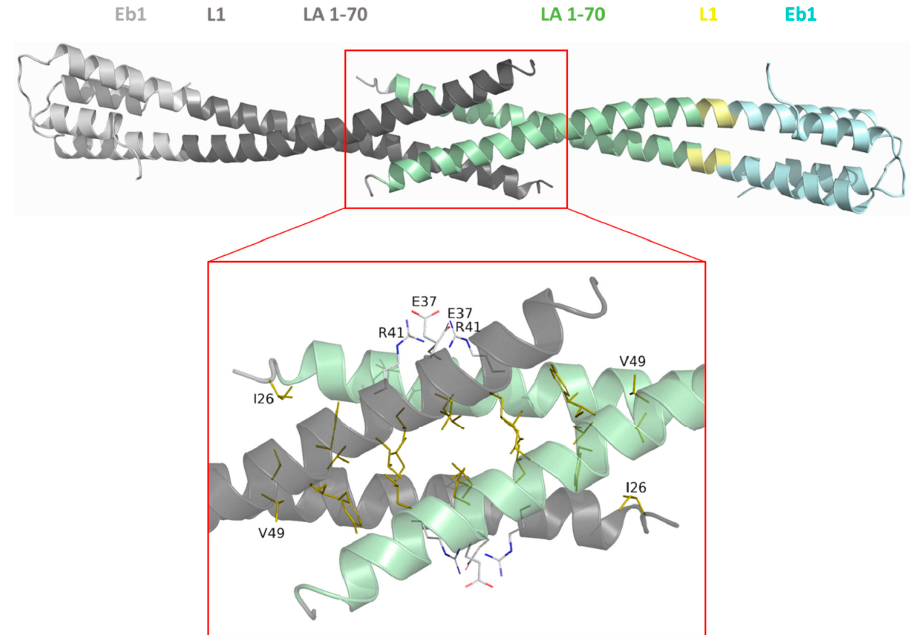
Figure 4. Crystal structure of LA 1-70-Eb1 dimer with coil1A in green, L1 region in yellow and the Eb1 cap in cyan. Additionally, a crystal symmetry mate is shown in black (lamin part) and grey (Eb1 cap). The zoomed area illustrates the interactions responsible for the antiparallel overlap of the N-terminal parts. Side chains forming the common hydrophobic core (coloured gold), as well as residues Glu37 and Arg41 forming salt bridges (coloured light grey) are shown.